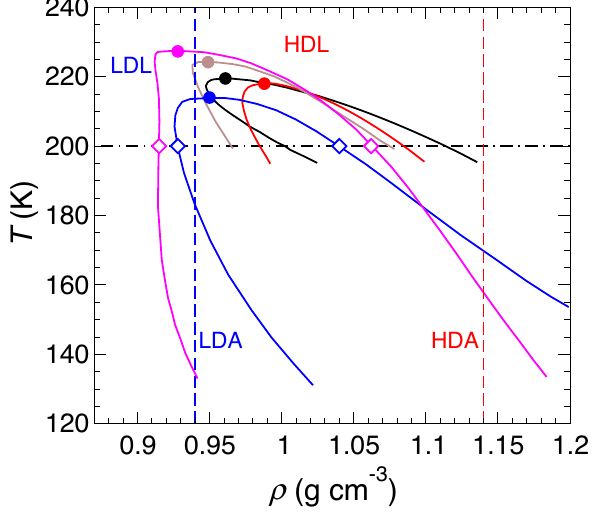
Fig. 1 | Comparison of estimates for the LDL – HDL binodal. Solid lines are binodals predicted from thermodynamic modeling of experimental data in ref. 11 (blue and brown), ref. 12 (magenta), and ref. 13 (black and red), with corresponding criticalpointsmarkedby fi lledcircles.Diamondslocatethecoexistencedensitiesof LDL and HDL at 200 K as determined by the magenta and blue binodals. Vertical dashed lines are isochores at the density of LDA (blue) and HDA (red) at T =80 K and ambient pressure 22 . The dot-dashed line is an isotherm at 200